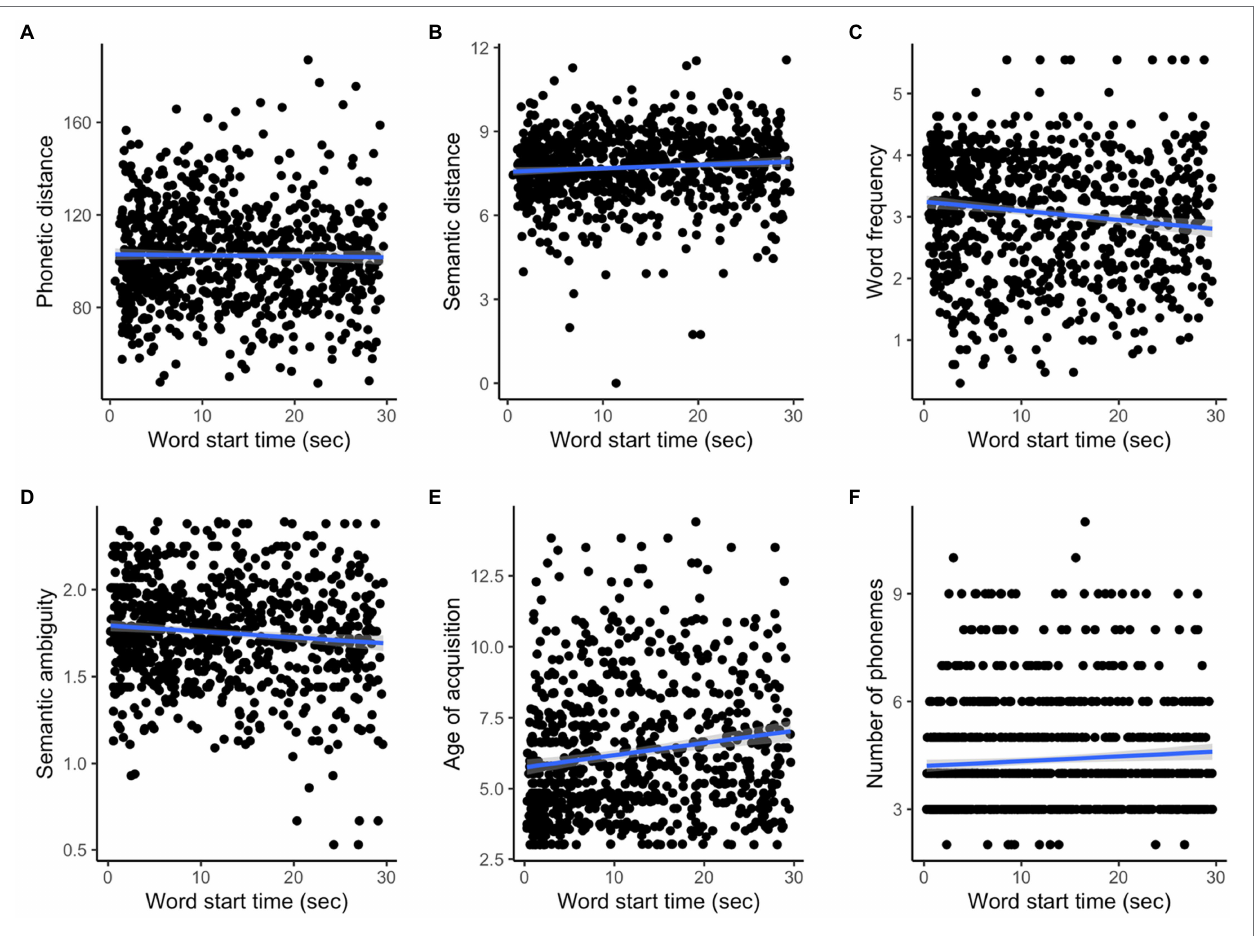
FIGURE 7 | Changes of the language measures over task